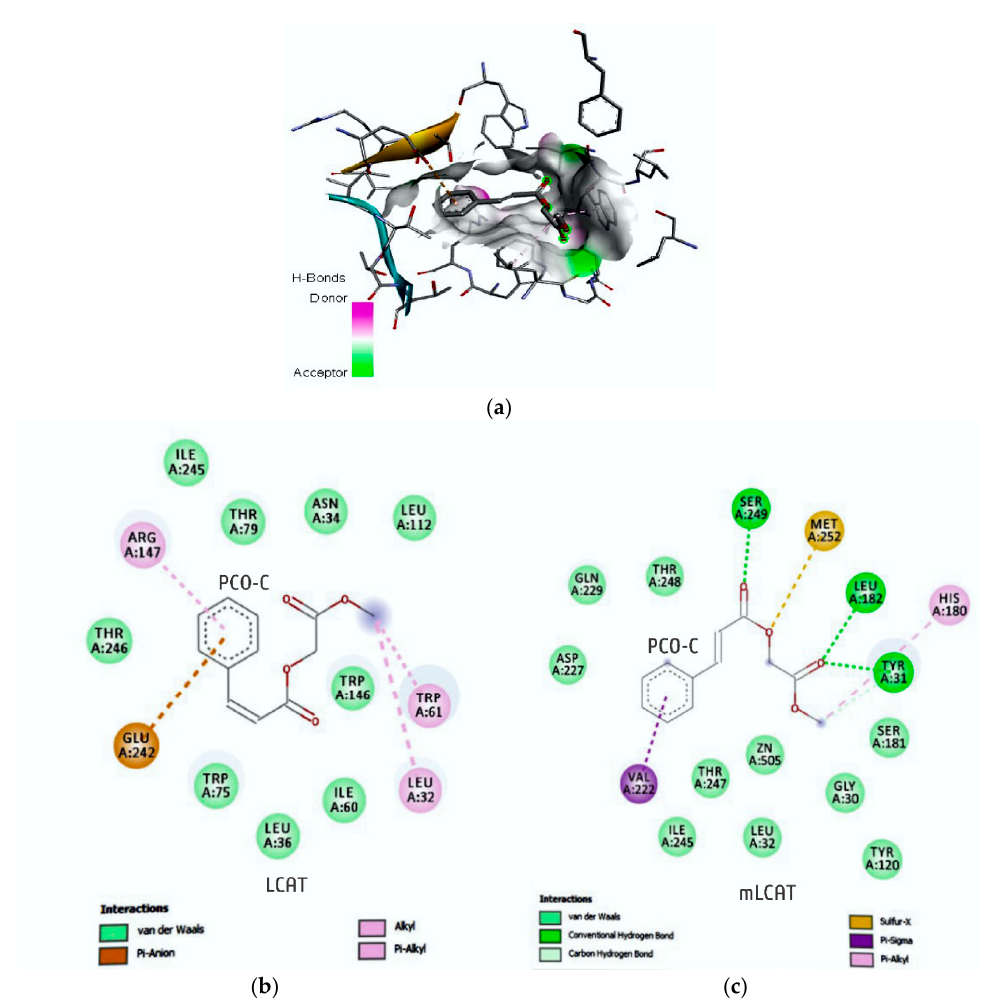
Figure 5. Three-dimensional (3D) ( a ) and two-dimensional (2D) ( b ) arrangement of residues involved in the interaction of PCO-C with nLCAT (presence of Cys31), interaction with mLCAT ( c ) (presence of Tyr31). The residues were observed by the Accelrys visualizer software, version 4.5.